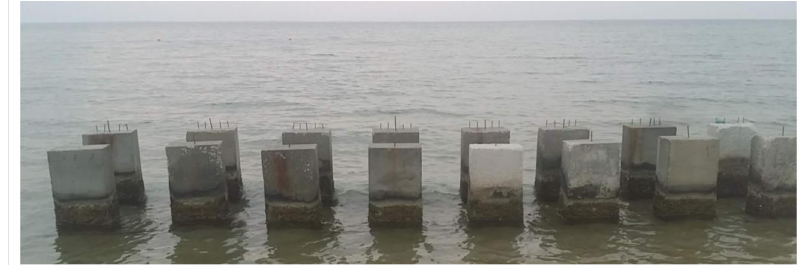
Figure 1. Concrete blocks setup in the tidal zone (inner blocks: reinforced; outer blocks: